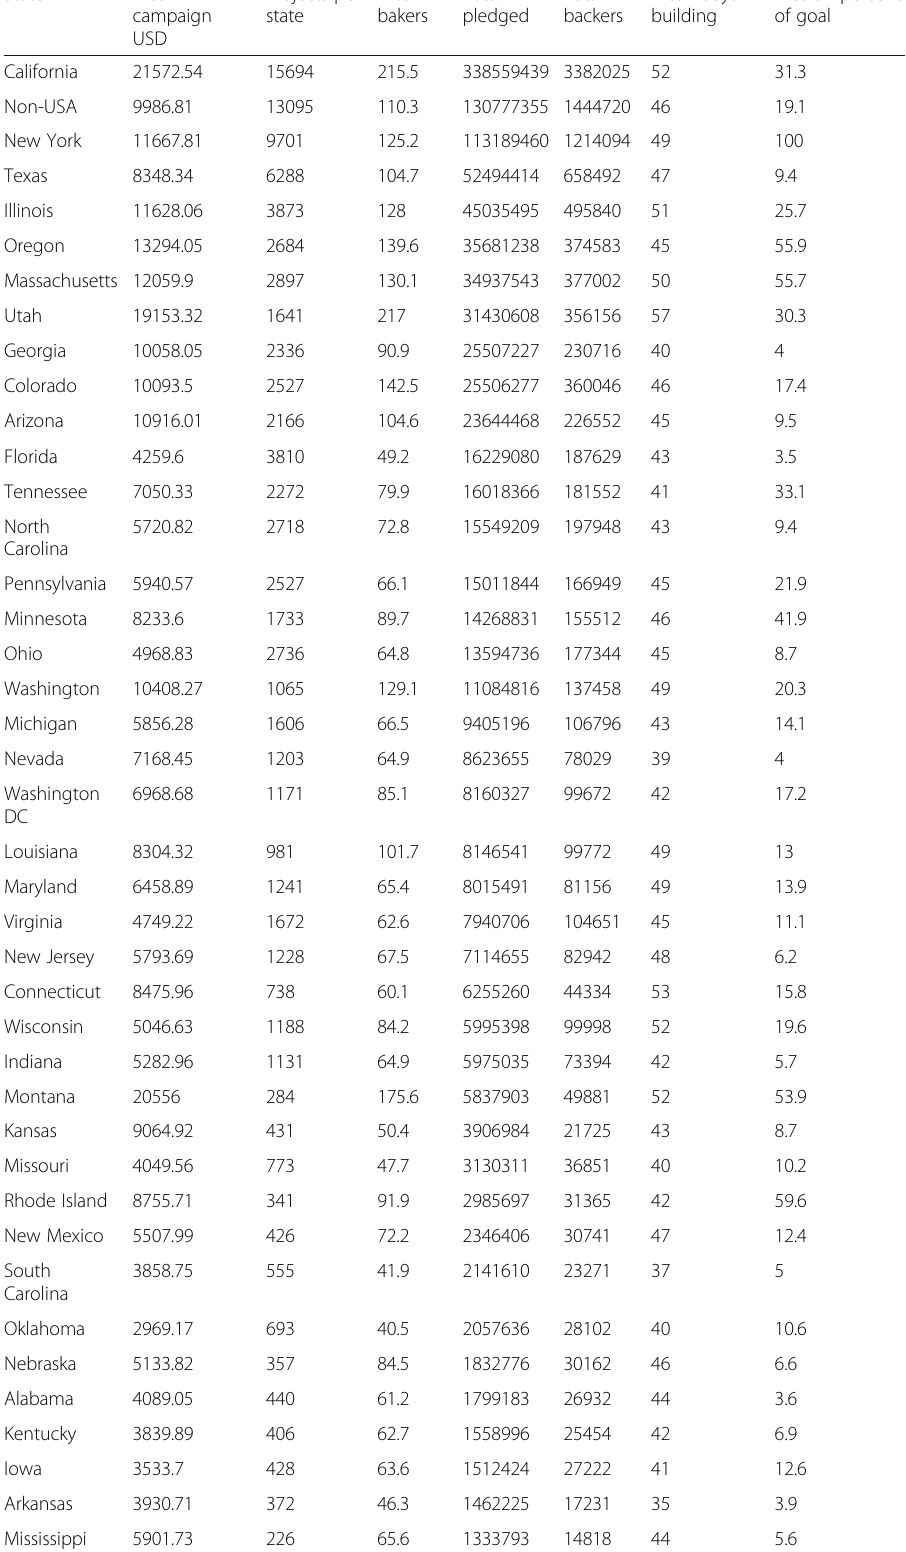
Table 2 US states descriptive